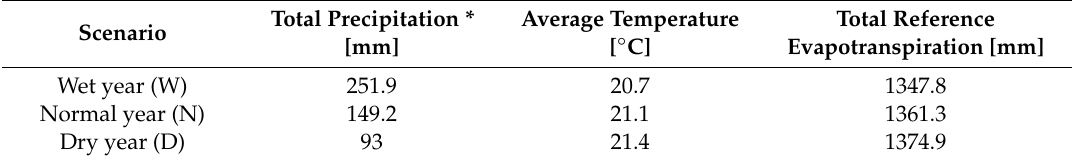
Table 1. Total precipitation and average temperature T at the station of Moires, Crete, during the dry season (March to November) for a Dry (D), Normal, and Dry (D) year and respective total ET 0 values calculated using Blaney-Criddle